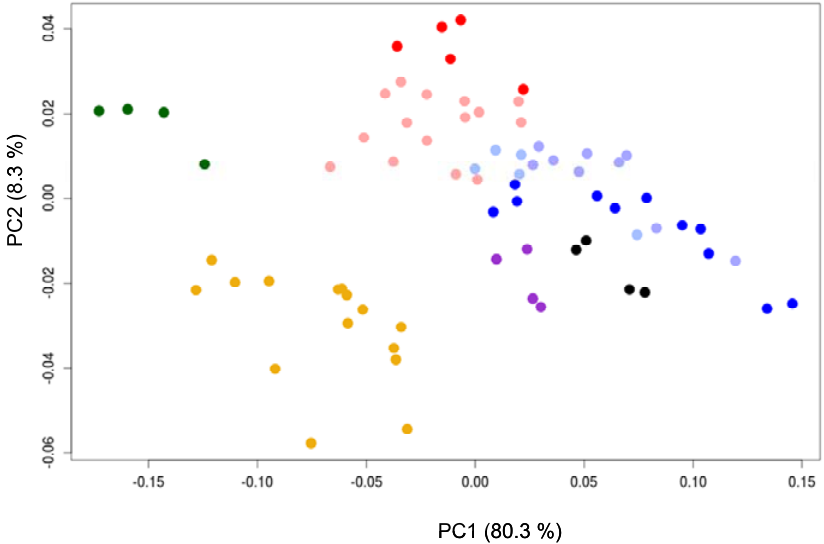
Figure 7. Functional PCA join results of first derivative of cyclic voltammetries obtained with Au WE in different adulterated and non-adulterated milk samples. La Serenisima M ( ● ); MSM ( ● ); USM ( ● ); Sancor M ( ● ); MSM ( ● ); USM ( ● ). Adulterant concentrations ranged between 2.43 and 0.1214 g·L − 1 for urea and between 1.7 and 0.085 g·L − 1 for melamine. For USM and MSM a graduation in the color intensity represents the adulteration percentage from 1 to 20%, where increasing intensity corresponds to a higher